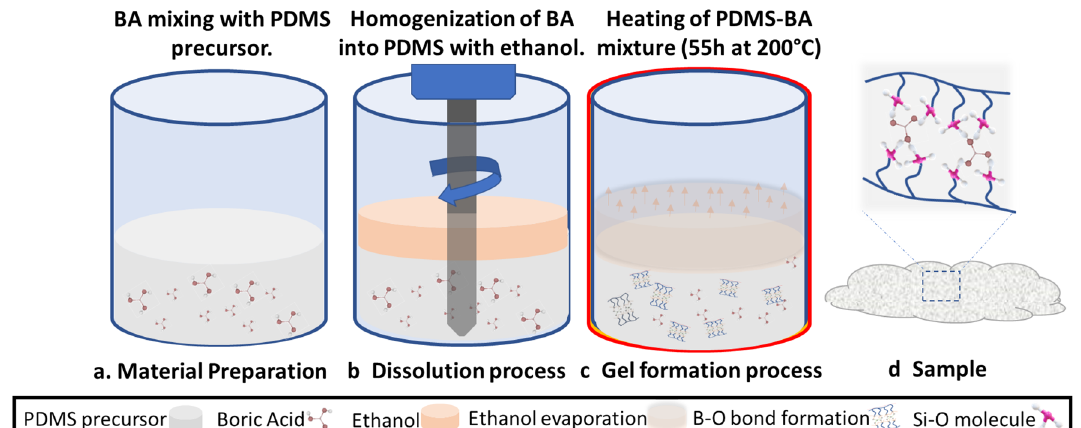
Figure 2. Schematic representation of the manufacturing process of